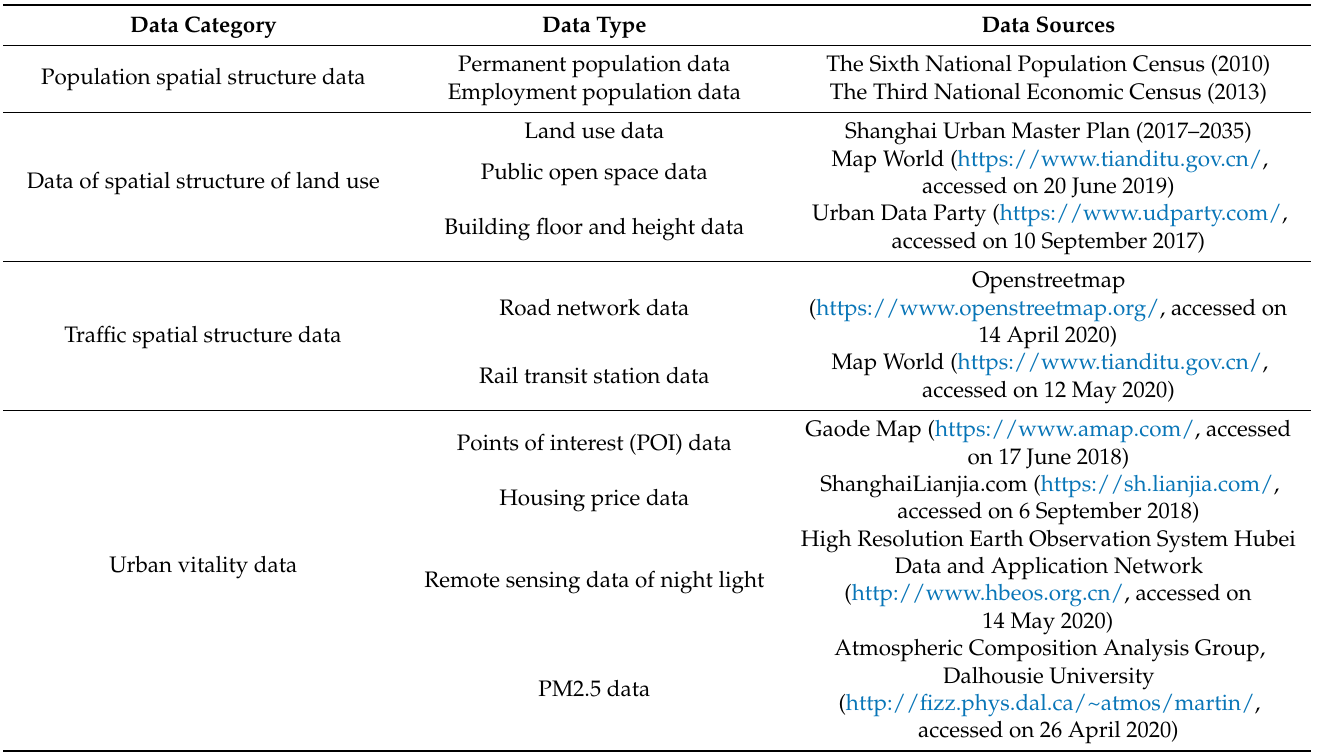
Table 2. Research data sources.